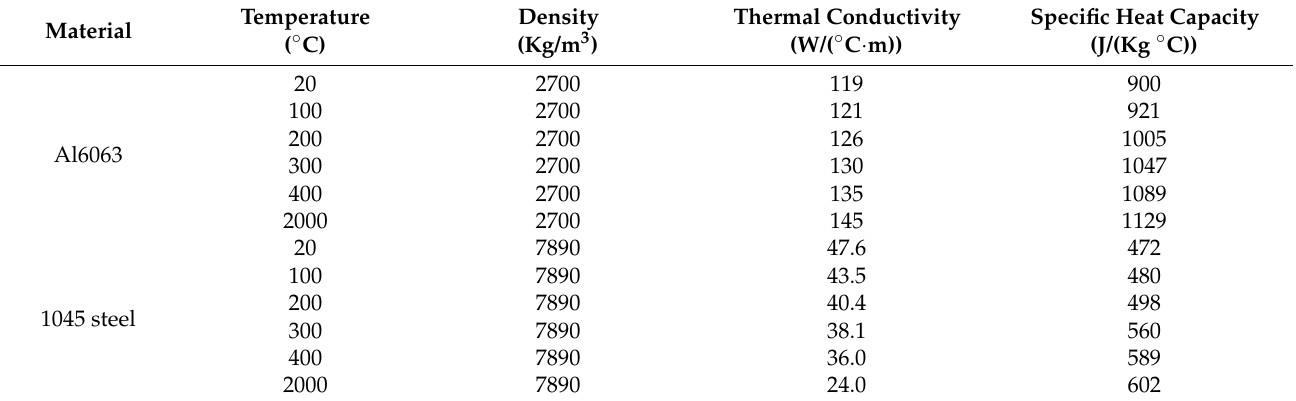
Table 1. Thermal property parameters of Al6063 and 1045 steel